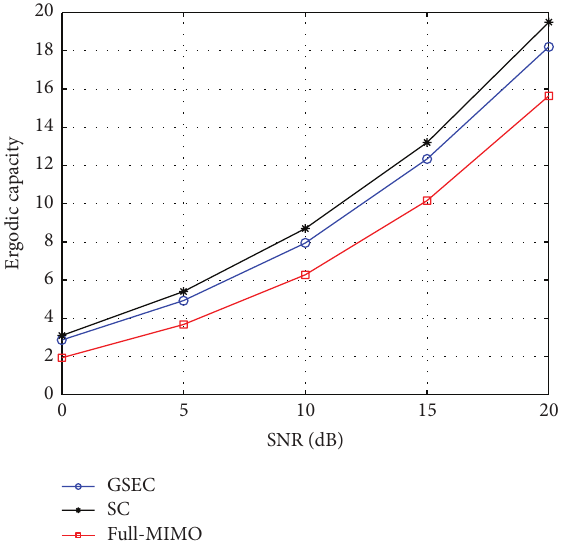
Figure 9: Effective ergodic capacity when 𝑇/Δ = ∞ ( 𝑁 𝑇 = 6 , 𝑁 𝑅 = = 6 , 𝐷 = 𝐷 = 2𝜆 ). 30 , 𝐿 𝑅 𝑇 𝑅